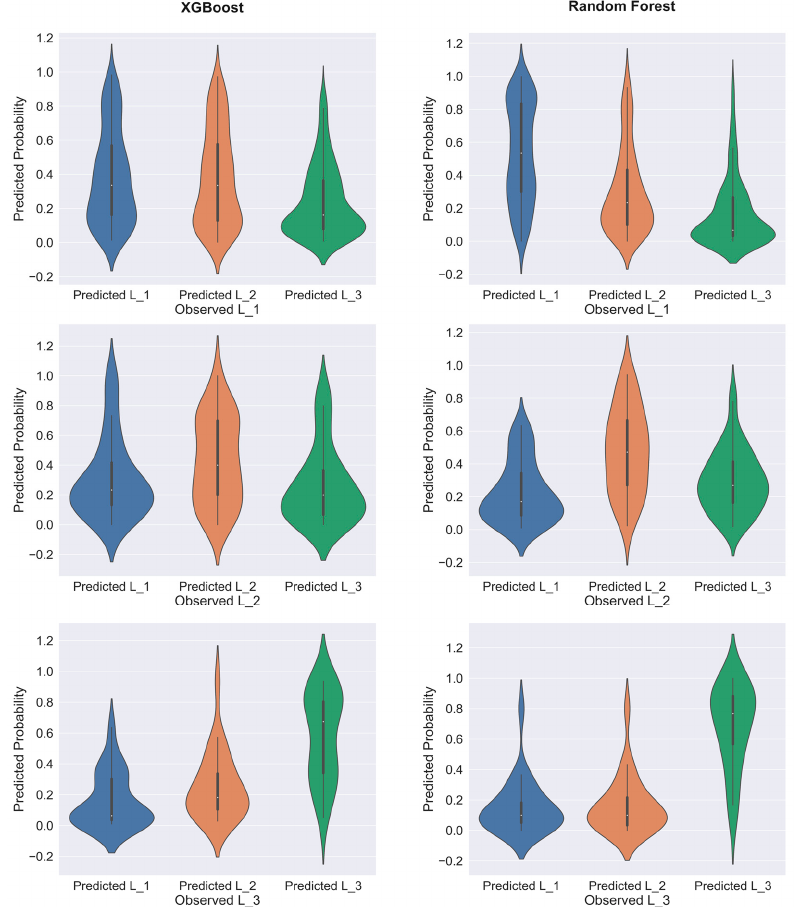
Figure 5. Predicted probability distribution of models trained by random forest and XGBoost. The test data are the same, and the training data are processed by different balancing algorithms: random forest uses SMOTEENN-balanced data and XGBoost uses RUS-balanced data.